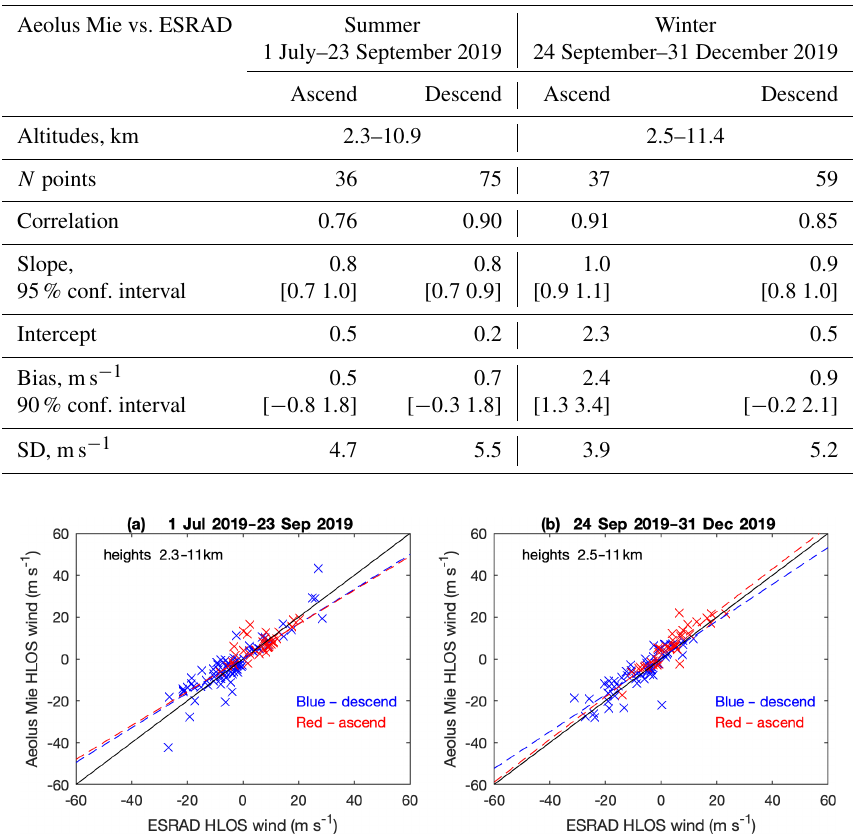
Table 5. Aeolus Mie–ESRAD HLOS wind comparison.